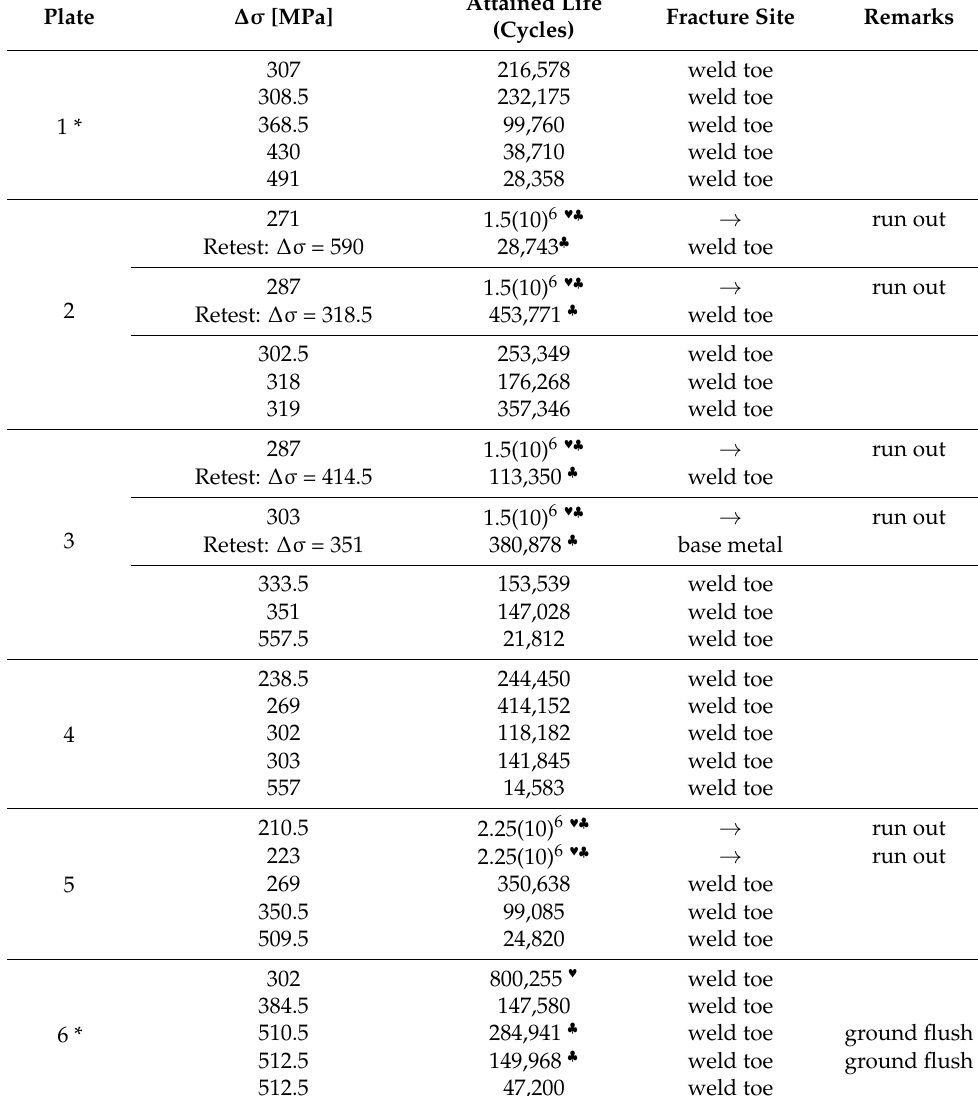
Table 4. List of NbMo modified 22MnB5 specimens with test condition and respective results.